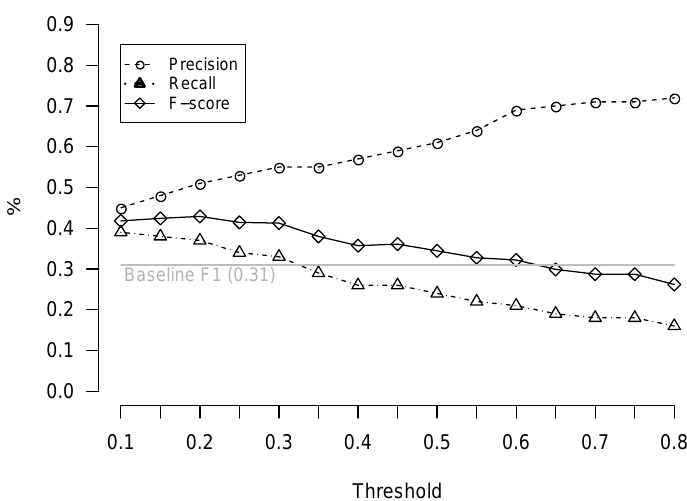
Figure 1: Trade-off between precision and recall across